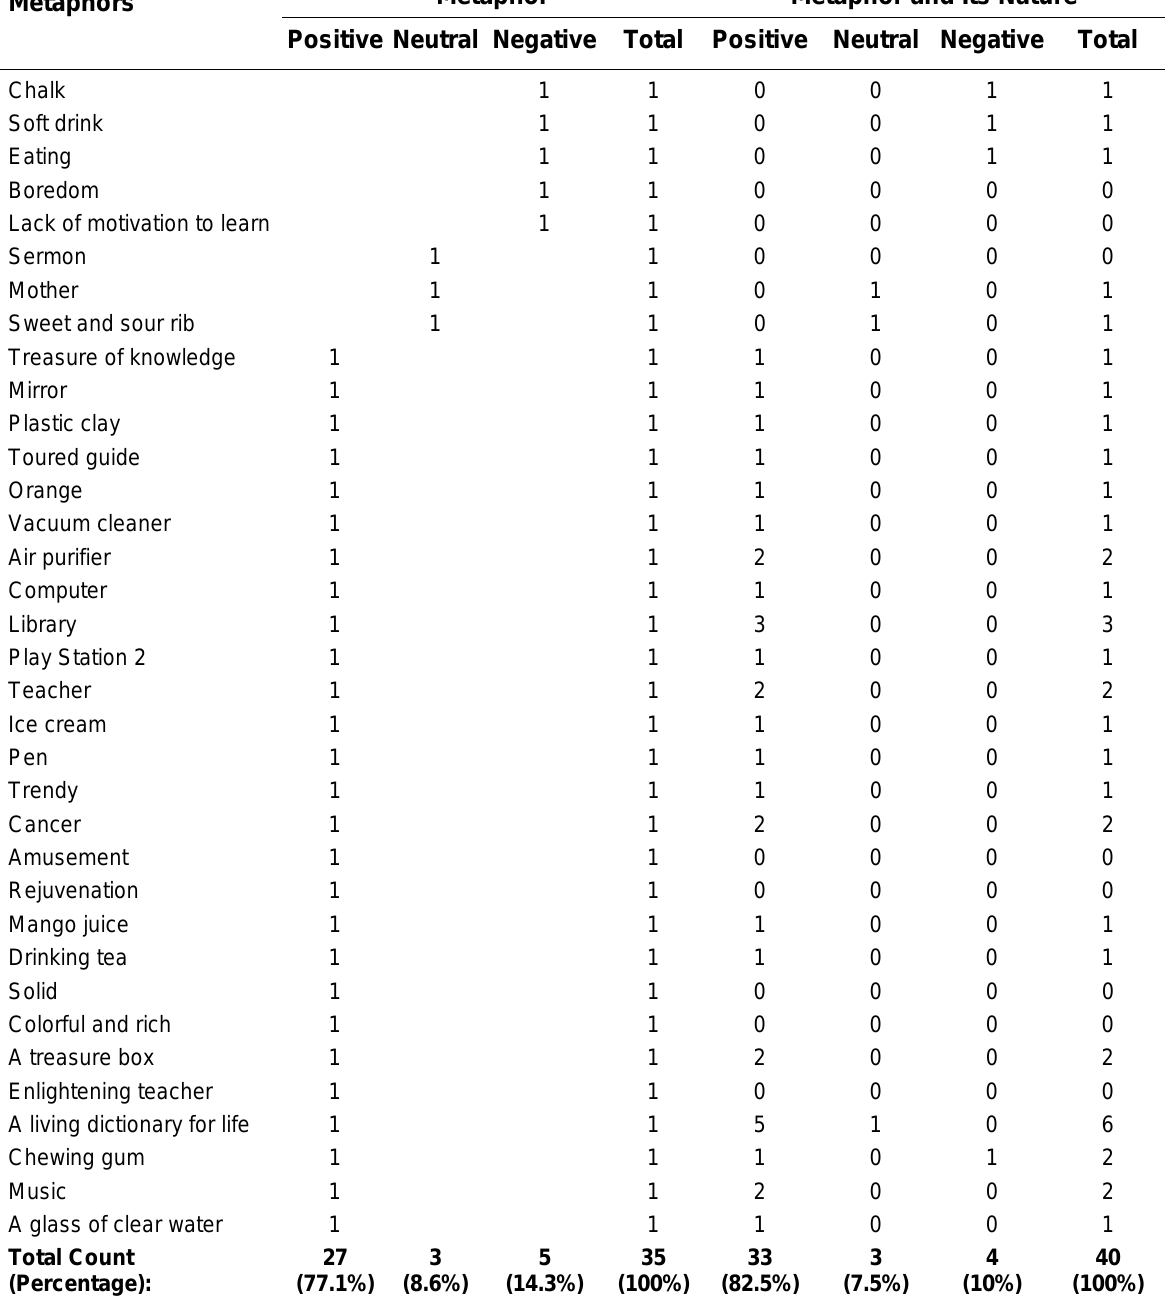
Categorization of the Metaphors (Incidents, Objects, Feelings, etc.) Used by the Participants Positive or Negative Nature of the Metaphor